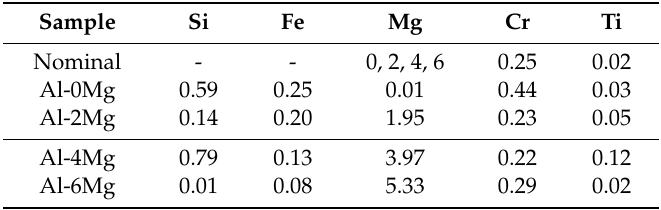
Table 1. Chemical composition (wt. %) of Al-Mg